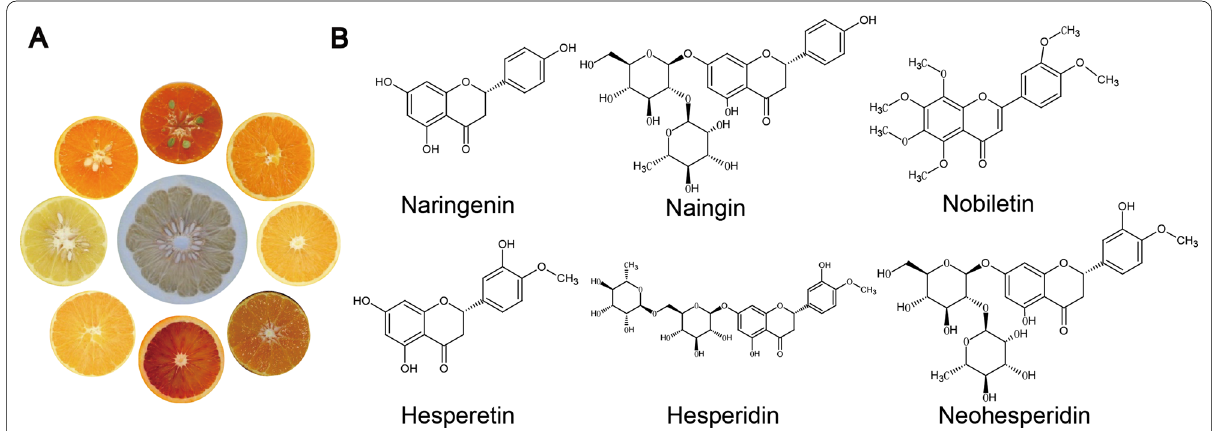
Fig. 1 Citrus fruits ( A ) and chemical structure of naringenin, naringin, nobiletin, hesperetin, hesperidin, and neohesperidin ( B